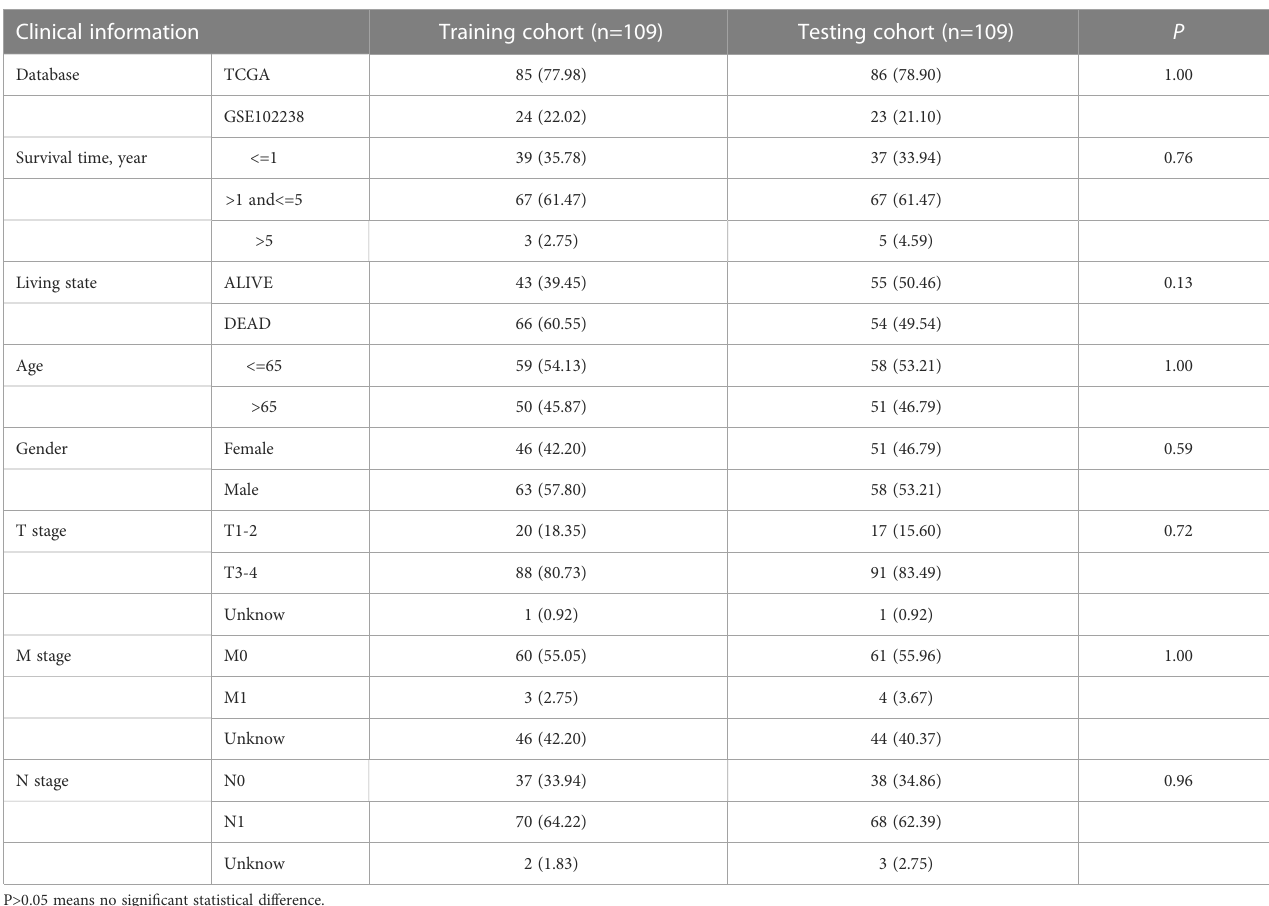
TABLE 1 Comparison of clinical data between the training and testing